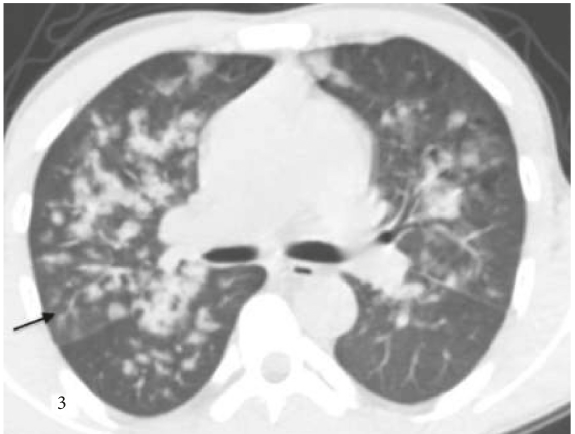
Figure 3: A 31-year-old male patient with influenza B pneumonia was also diagnosed with known end-stage renal disease. The score was evaluated as 2 according to CORADS classification and in the atypical group according to the RSNA guidelines. Soft tissue density centrilobular nodules (black arrow) forming tree in bud pattern and peribronchovascular